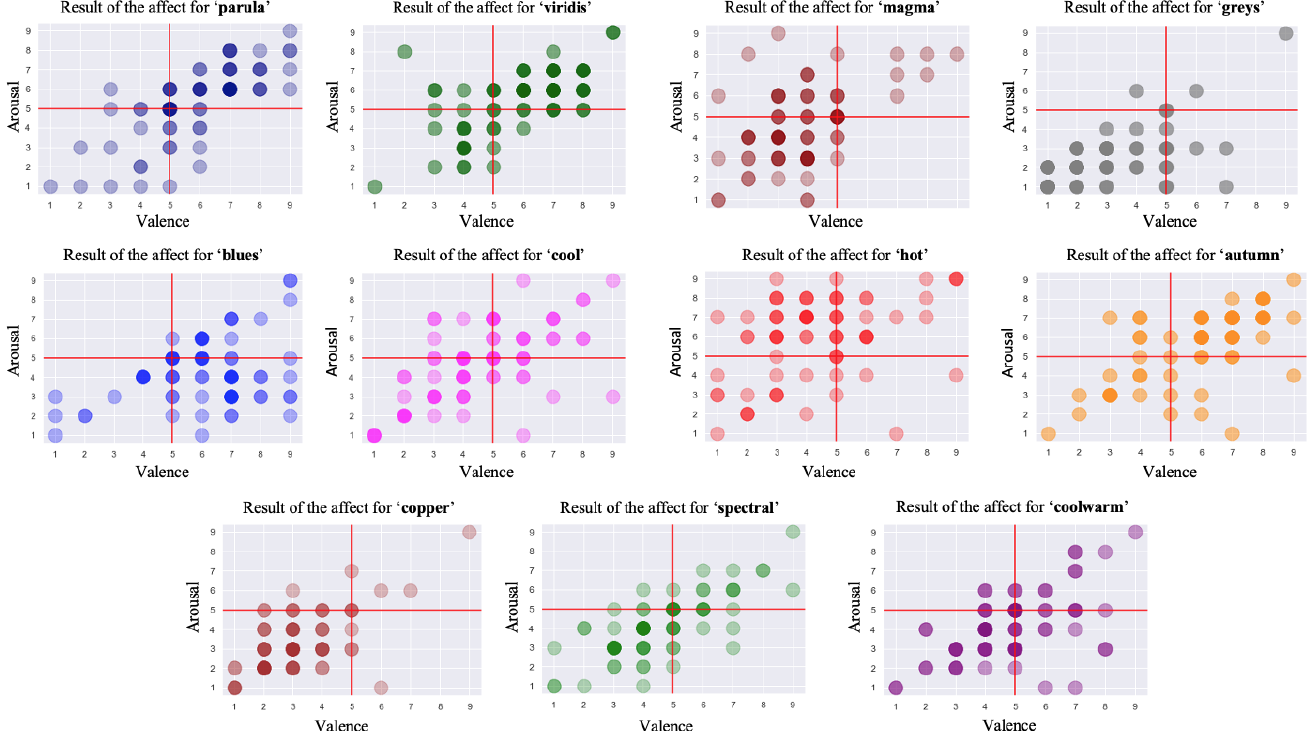
Figure 7. The overall result of the 11 colomaps regarding the affect evoked in the valence–arousal coordinate system. Each colormap was assigned an exclusive color in this outcome visualization for better visibility and interpretability. The circles with darker chromatic concentration represent more than one answer in those positions: the darker the circle, the greater the number of the same results. Using the data collected in valence and arousal dimensions, the individual distribution of each colormap is depicted in Figures 8 and 9. From these figures, we can derive a preliminary impression of which colormaps trigger affect in which quadrants of the emotional coordinate system. Thus, we can plot the synthetic distribution of the 11 colomaps of the affect evoked according to the arithmetic mean values of the two affective dimensions in one single plot (Figure 10). From our aggregated data acquired from the results and the visualized plots, it is fair to conclude that colormaps parula , viridis and autumn trigger emotions mostly in the positive–exciting quadrant. Conversely, coolwarm , spectral , magma , greys , copper and cool incite the affect mainly in the negative-calm quadrant. The remaining colormaps blues and hot are in the positive-calm and negative- exciting quadrants